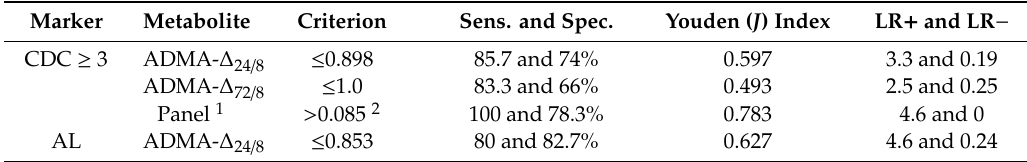
Table 11. Characteristics of ADMA as an indicator of operative comorbidities and a marker of anastomotic